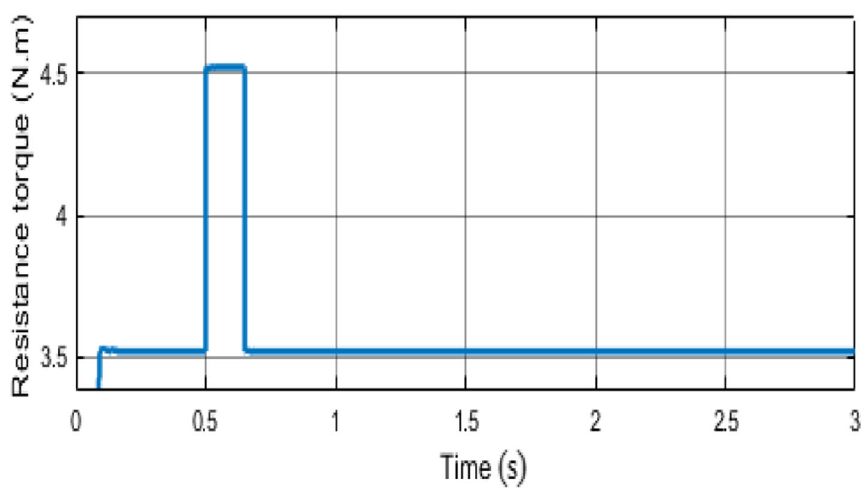
Fig. 19 Load torque